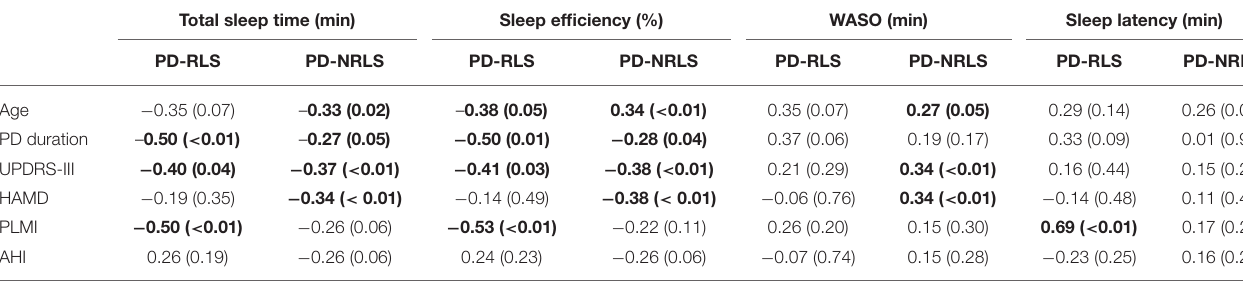
TABLE 3 | Correlations between sleep parameters and clinical